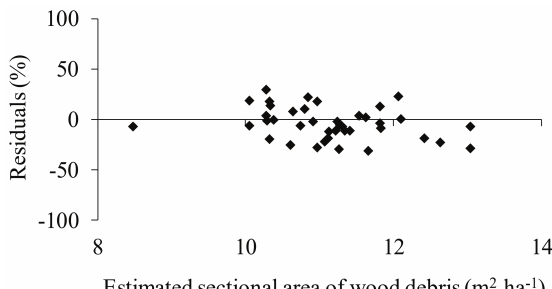
Figure 5 - Residuals of the sum of woody debris cross-sectional areas obtained by ratio estimate in an urban mixed tropical